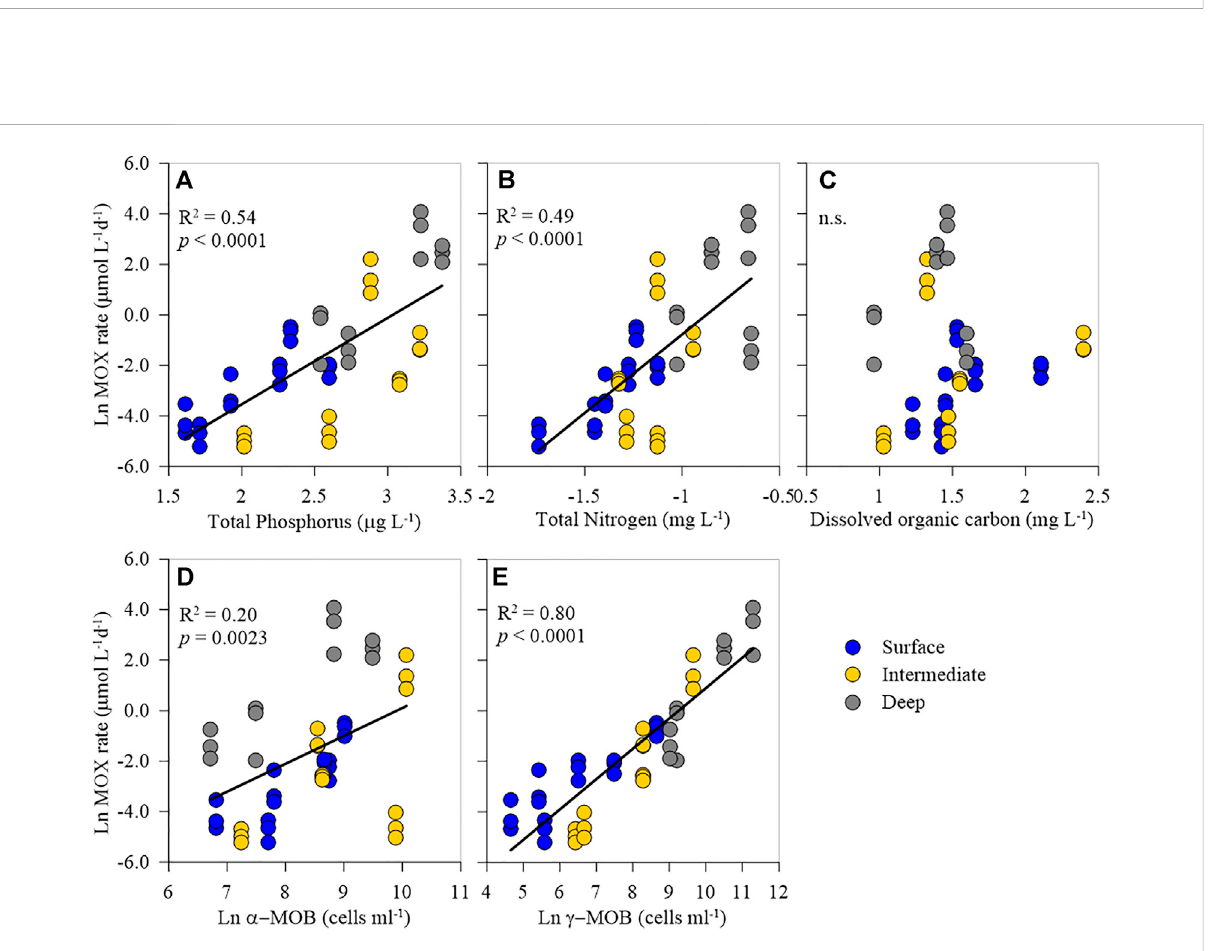
Relationships betweenmethaneoxidationrate(MOX)andtotalphosphorus (A) ,totalnitrogen (B) ,dissolved organiccarbon (C) ,andabundance of α -MOB (D) and γ -MOB (E)